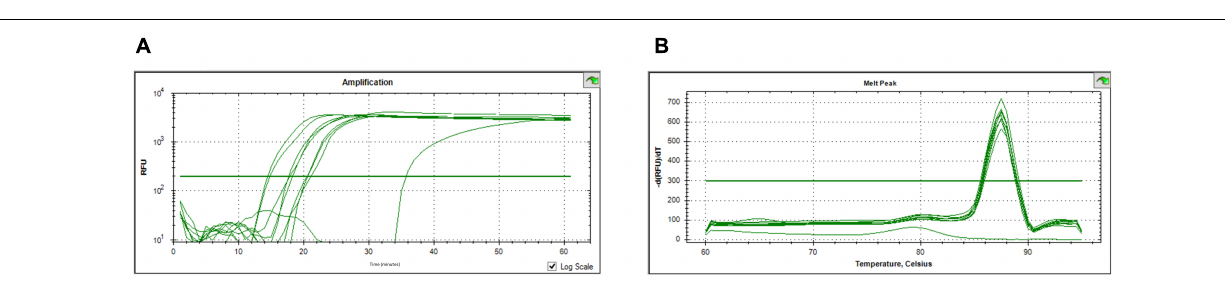
FIGURE 4 | Results of the O. oeni detection and quantification by SYTO-9 fluorescence-based Cells-qLAMP. (A) Relative fluorescence units (RFU) vs. time; (B) The melting curves analysis of the amplified